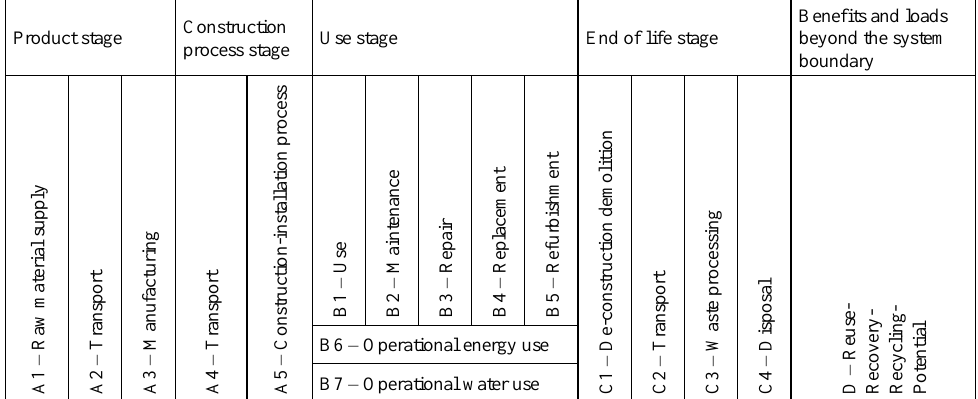
Fig. 3. Life Cycle Modules in accordance with EN 15804. Source: EN 158